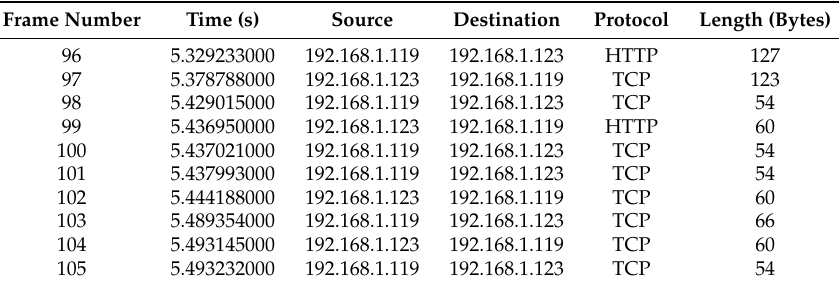
Table 3. Network packet analysis of an ID request to an